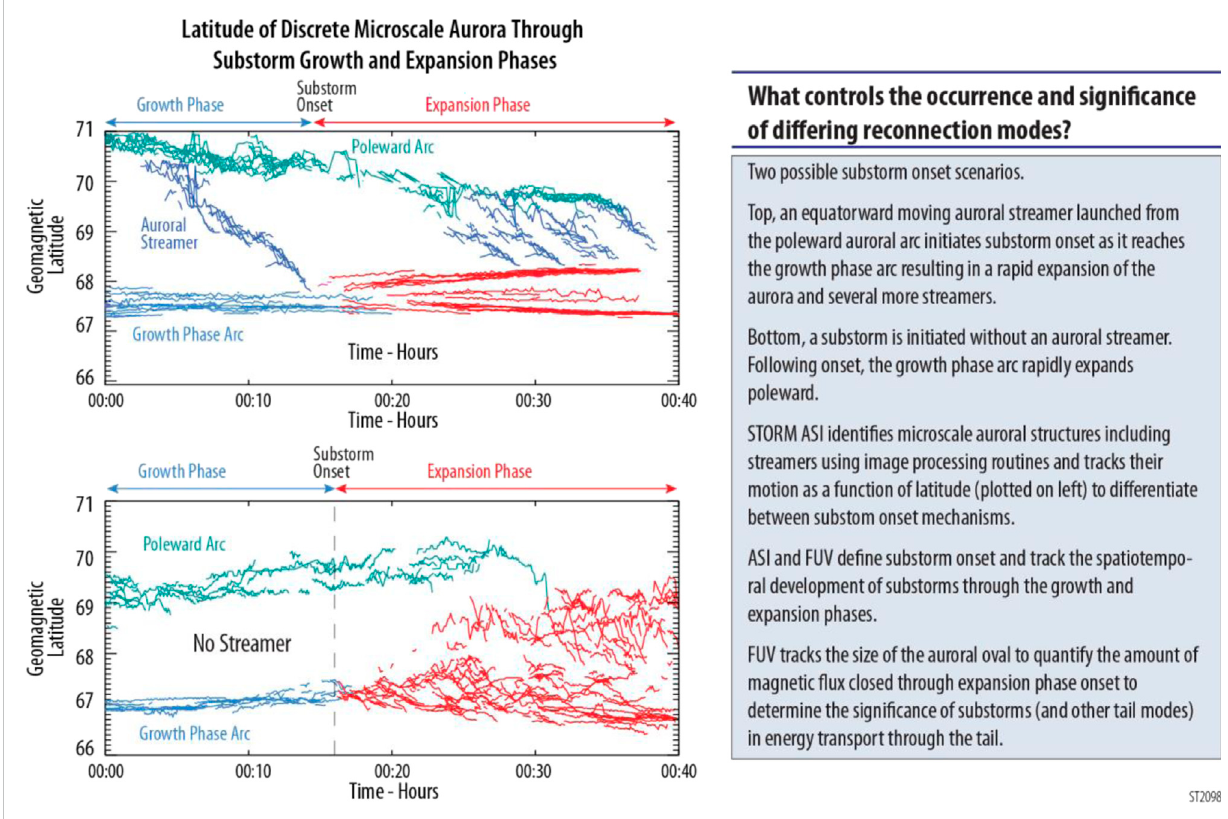
FIGURE 5 AnexampleofhowSTORMdifferentiatesbetweensubstormsinitiatedbystreamersandthoseinwhichonsetisspontaneous.Left,imageprocessing techniques identify and track discrete microscale auroral forms in the fi elds-of-view of an all-sky imager. This process allows researchers to quantify discrete aurora (position and velocity), reduce thedimensionality of ASI images (from 3 to 2), and rapidly identify streamers (top)during the growth phase of substorm and whether they do (top) or do not (bottom) initiate a substorm. Right, a description of STORM ’ s methodology to address objective